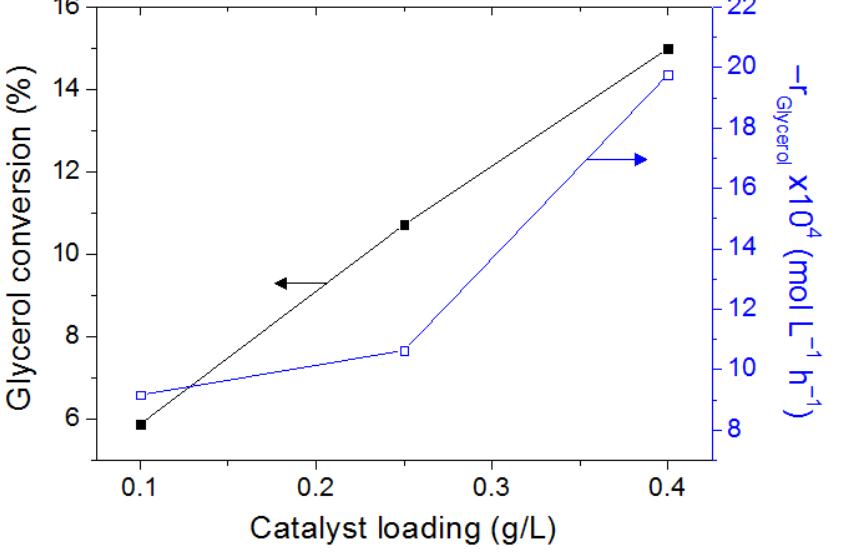
Figure 7. Effect of catalyst concentration on glycerol conversion and initial reaction rate (Initial glycerol concentration = 6.25 × 10 −2 M, T = 305.65 K, Cu/TiO 2 catalyst).